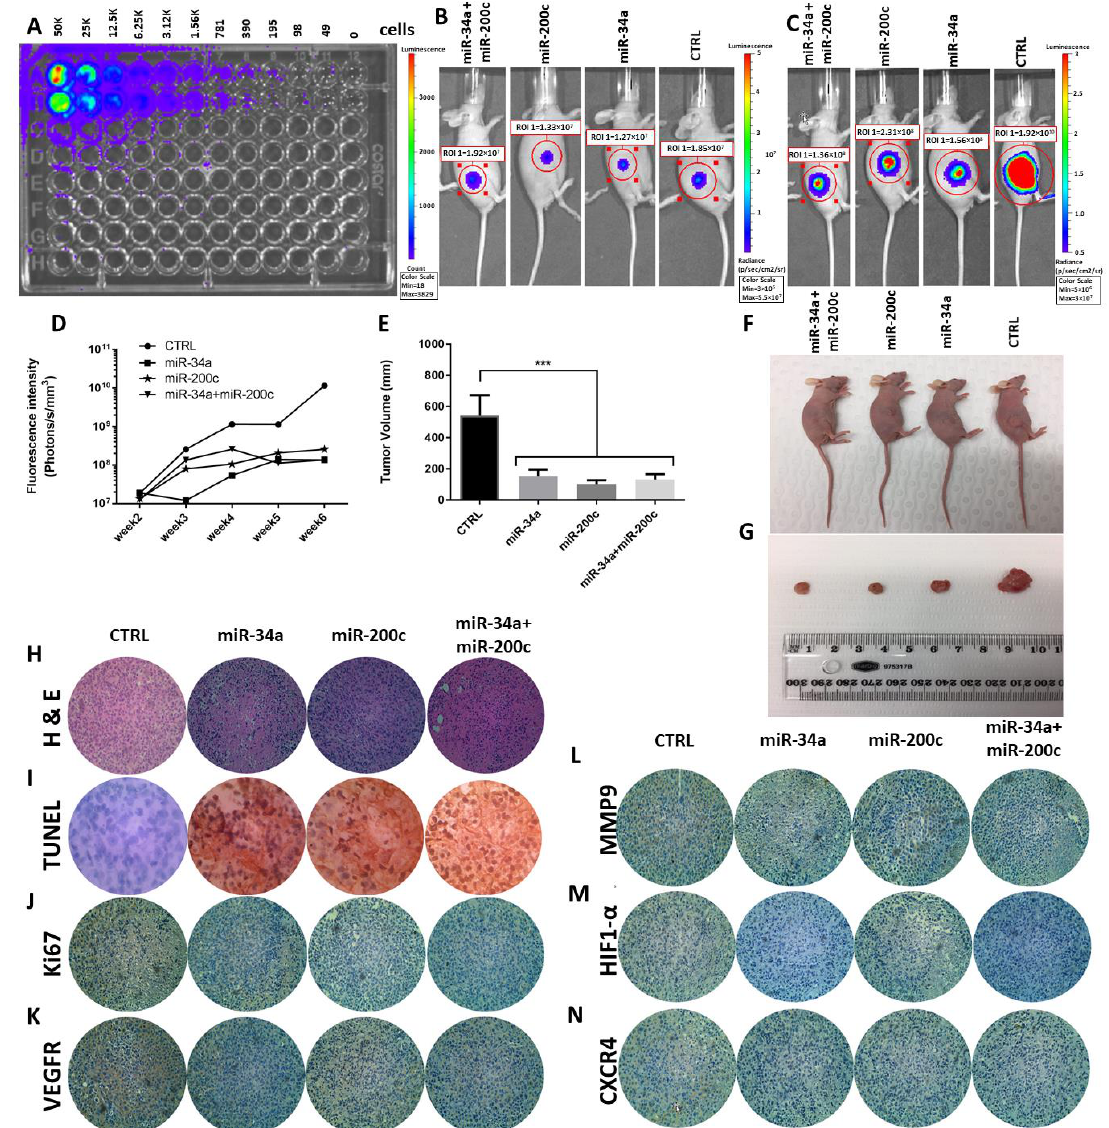
Figure 5. Individual and co-delivery of miR-34a and mir-200c suppress cancer development in a xenograft mouse model. ( A ) Bioluminescence imaging of serially diluted MDA-MB-231 cells, which stably express luciferase. ( B ) Bioluminescence imaging of mice with tumor formation prior to miRNA treatment. ( C ) Bioluminescence imaging of mice after intra-tumor injections with indicated miRNAs. ( D ) Quantification of bioluminescence intensities of mouse tumors after intra-tumor injections with indicated miRNAs. Measurements of tumor volumes ( E ), Images of mice ( F ), excised tumors ( G ) for indicated groups. ***, p < 0.001. ( H , I ) H&E staining on each tumor ( H ) and TUNEL assay to show apoptosis induction ( I ) after miRNA transfection. ( J – N ) Immunohistochemistry staining for Ki67, VEGFR, MMP9, HIF1- α and CXCR4,